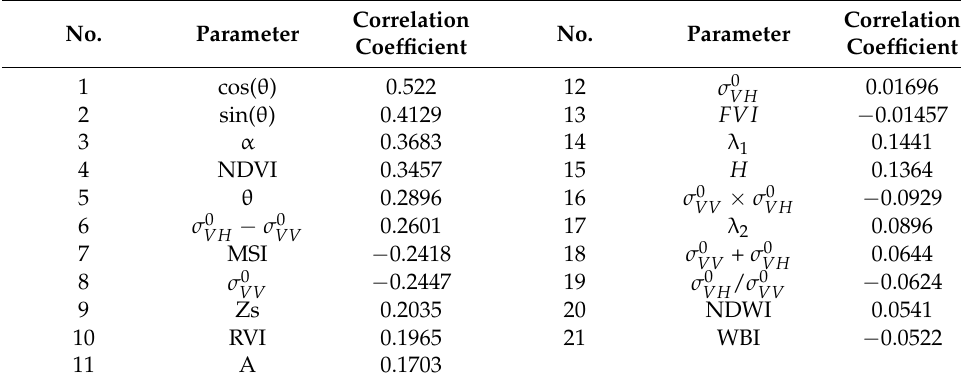
Table 5. Ranking of feature importance using RF method. No.